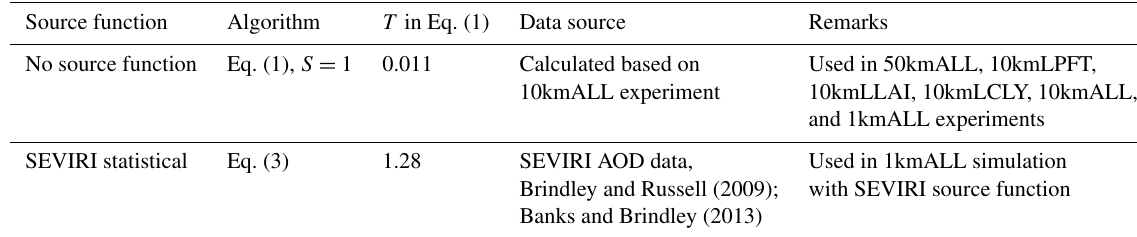
Table 4. Tuning constants used in the simulations. Source